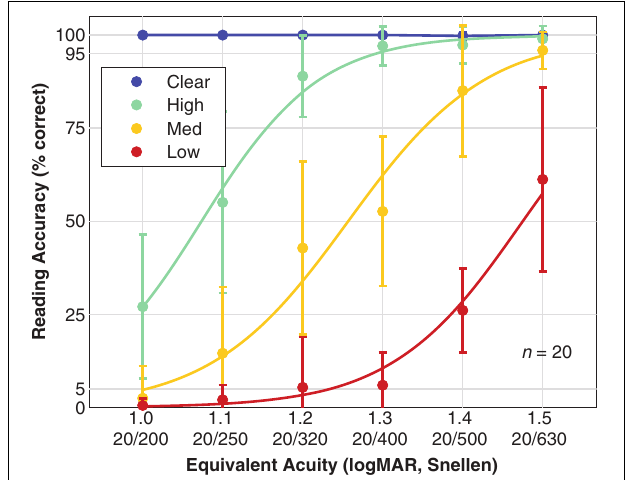
FIGURE 6 | Reading accuracy. Population reading accuracy vs. font size, expressed as equivalent acuity is shown. Data have been grouped by viewing condition: Clear (blue; text presented in the clear as a control condition), High density phosphene pattern (green), Medium density pattern (yellow), and Low density pattern (red). Data points are the mean, error bars are the standard deviation of population values. Smooth curves are logistic fits with assumed asymptotes of 0 and 100% for all three phosphene vision conditions.